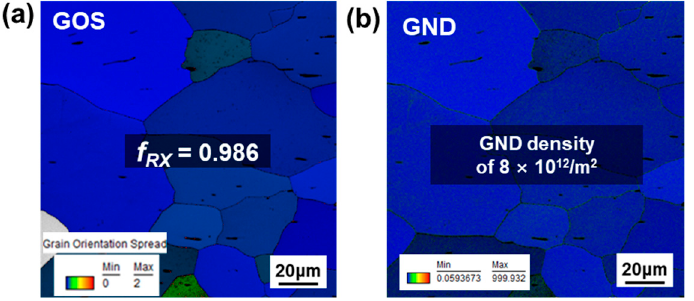
Figure 4. The EBSD analysis results of undeformed RX-W sample: ( a ) GOS map and ( b ) GND map.